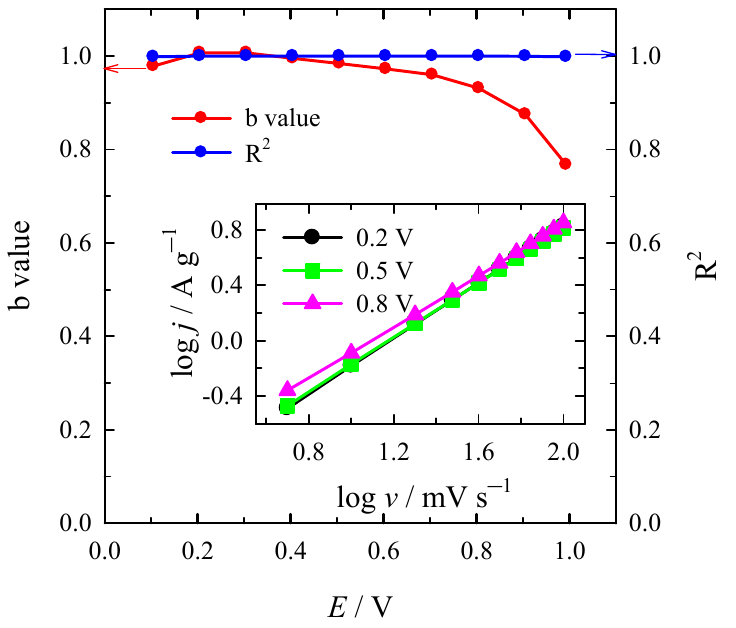
Figure 8. The b value under anode scan and its corresponding fitting variance R 2 for the NC-ABL-WC. Additionally, the CV analysis was performed on Duun’s method [61], allowing evaluat- ing the contribution of the surface control capacitance and the diffusion control capacitance to the total capacitance (Equation (3)):